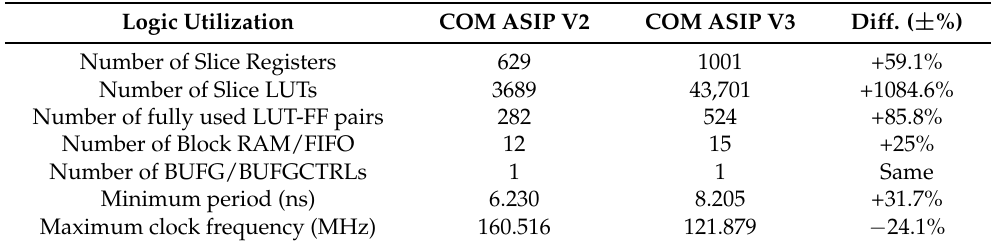
Table 6. Comparison between logic utilization of COM ASIP V2 and COM ASIP